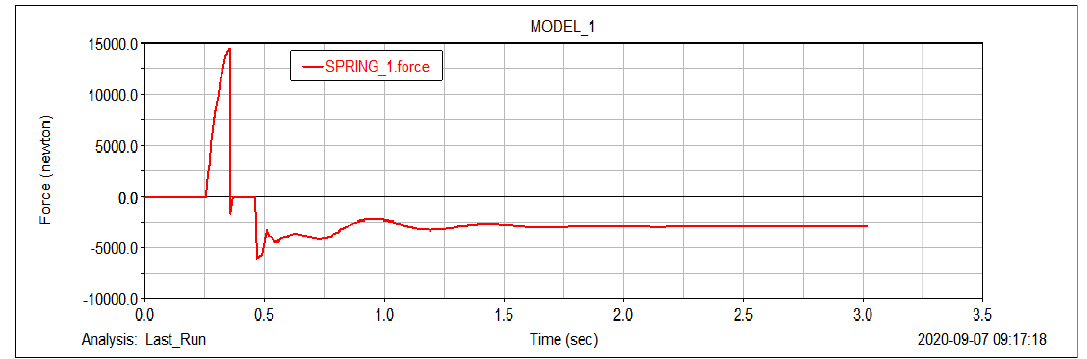
Figure 13. Vertical impact force computed form hard landing case simulation at 20% (320 kg) of aircraft maximum takeoff weight on nose landing